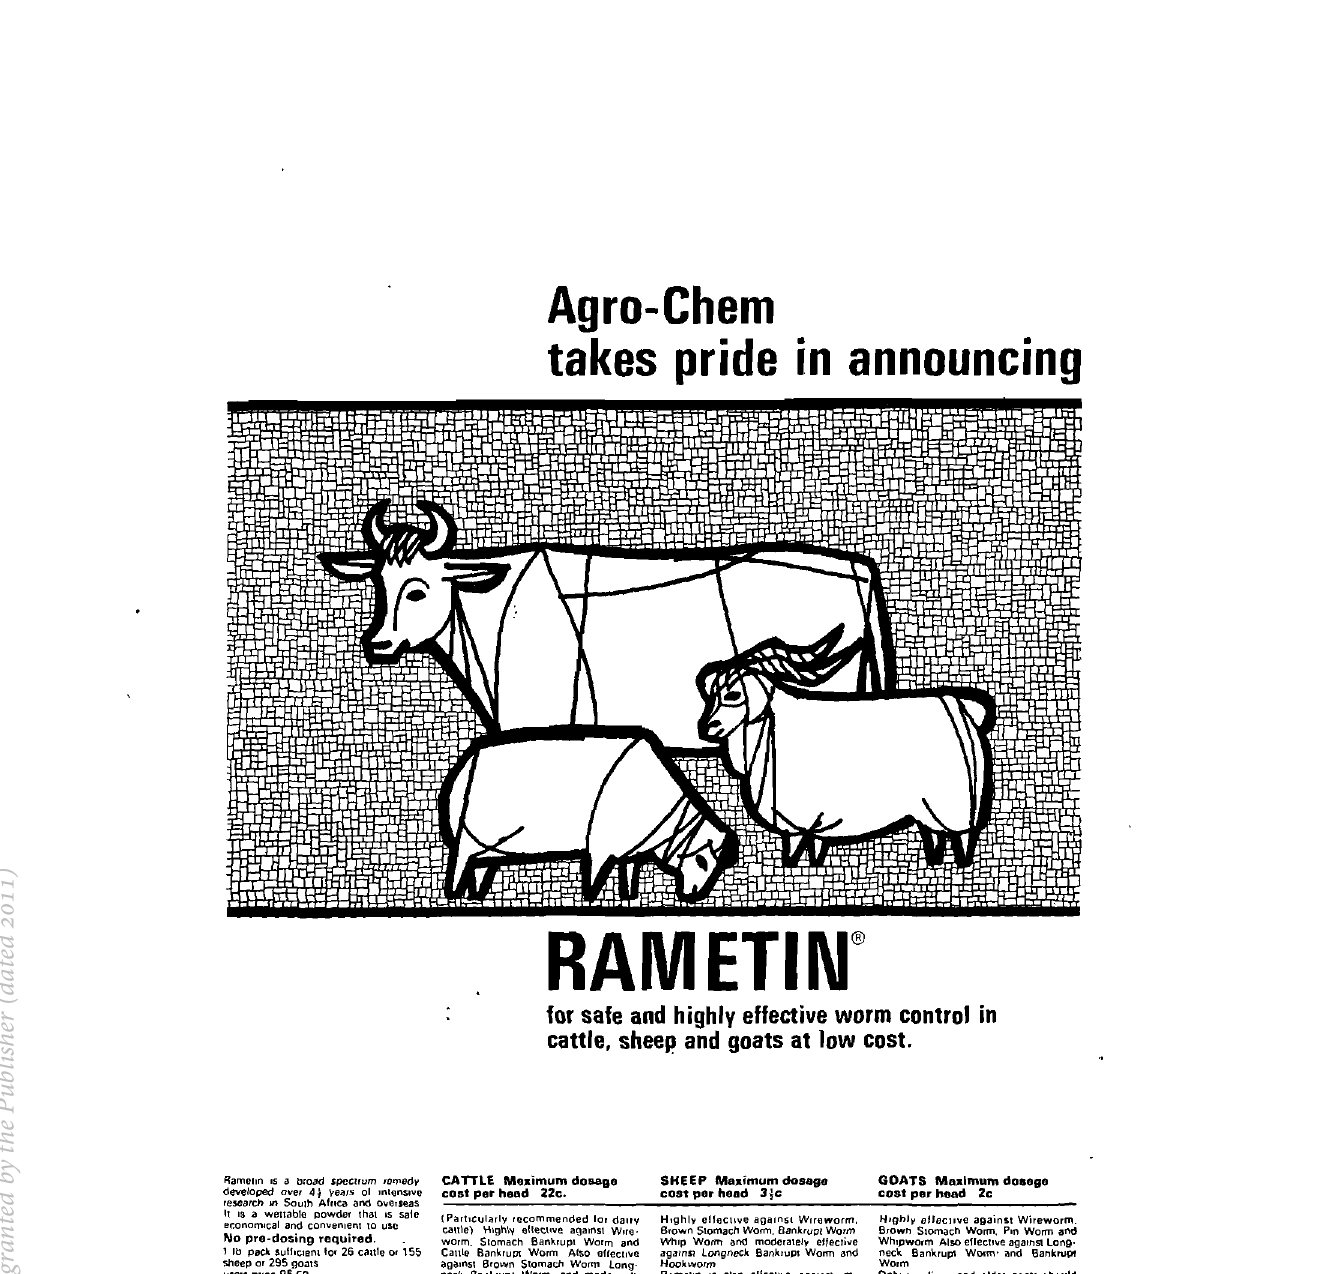
SHEEP MOllimum dosage cost per head 3-;-c H.ghly ellecHve agaInst WIreworm, Brown Stomach Worm, BankruPI Worm WhIp Worm and moderately elfeclive again$? long neCk Banklu~1I Worm and Hookworm Rametln IS also elfeclIvc agam51 ,m malu·ewormt> MANUFACTURfO BY BAYER lEVERKUSEN . o RAMElIf't 'ii. InEt regl5lered u .. dernllf. 01 SAYER LEVERKUSEN